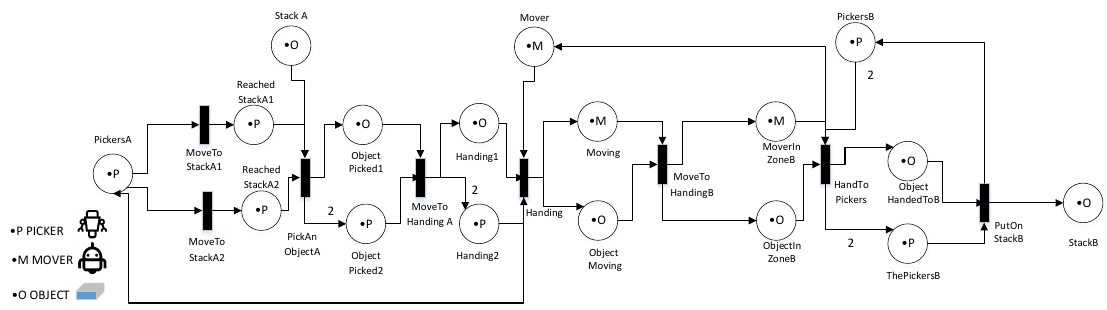
Figure 5. Two different types of mobile robots cooperate together to move a stack of objects from zone A to zone